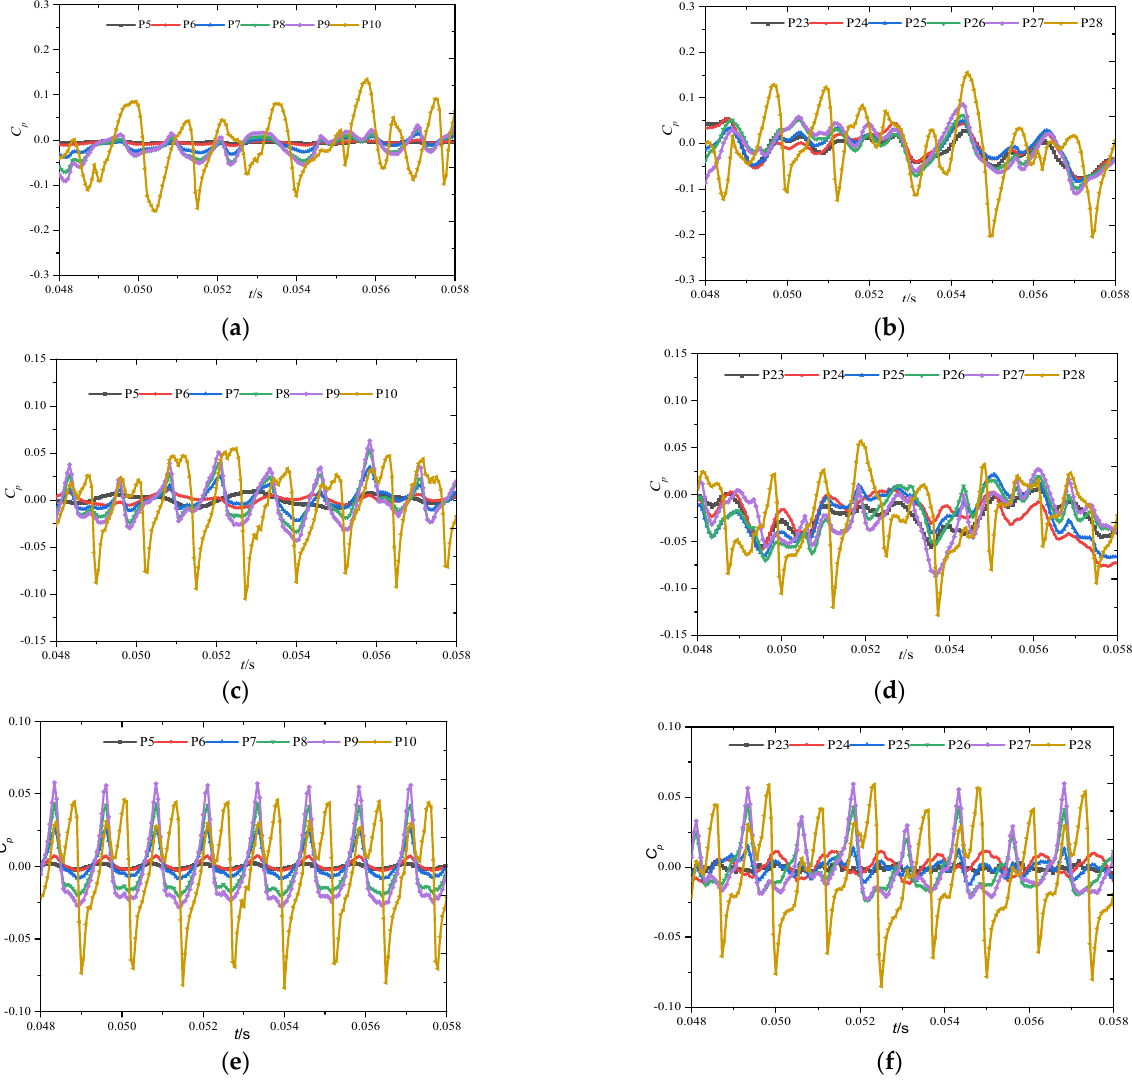
Figure 9. Time domain diagram of the pressure pulsation of impellers at all levels under non-cavitation conditions: ( a ) 0.6 Q des − primary impeller; ( b ) 0.6 Q des − secondary impeller; ( c ) 1.0 Q des − primary impeller; ( d ) 1.0 Q des − secondary impeller; ( e ) 1.4 Q des − primary impeller and ( f ) 1.4 Q des − secondary impeller.